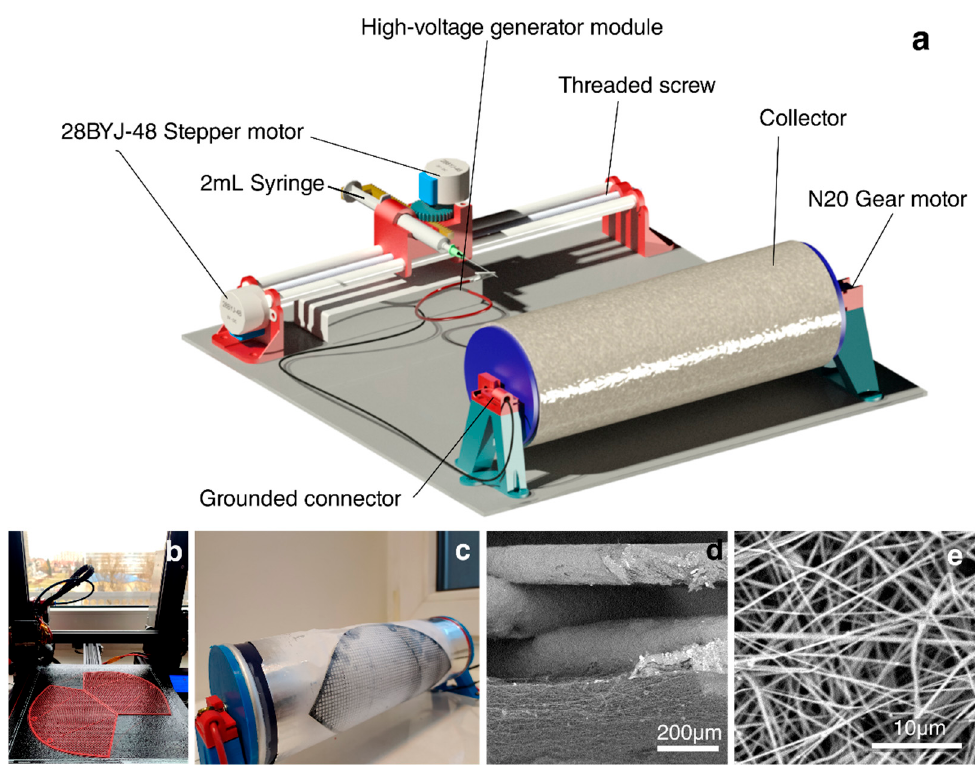
Figure 1. ( a ) Illustration of the 3D ‐ printed simplified electrospinning setup; ( b ) 3D printing of the filter mask support; ( c ) electrospinning of the fibers over the 3D ‐ printed PLA support; SEM images (( d ): cross-section; ( e ): top-view) of electrospun nanofibers.